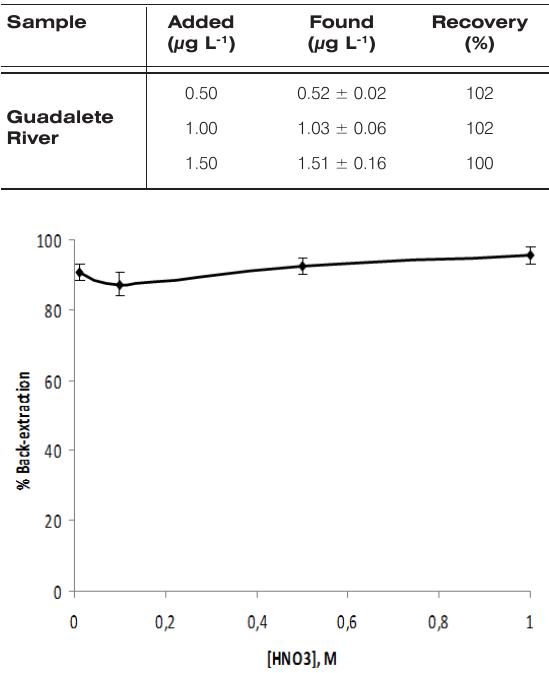
Figure 5. Effect of HNO